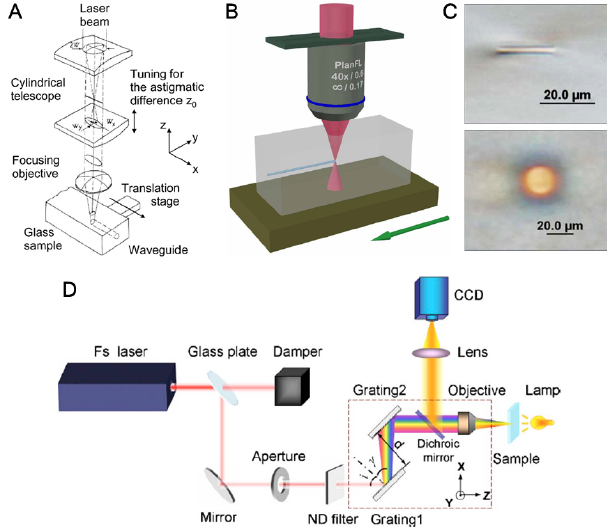
Figure 5: (A) Astigmatic beam shaping using a cylindrical telescope in front of the focusing objective. With permission from [69]. Copy- right 2003 The Optical Society. (B) Slit beam shaping, reducing the numerical aperture and thus expanding the focal spot transverse to the translation direction. With permission from [165]. Copyright 2009 The Optical Society. (C) Effect of the slit beam shaping on the waveguide cross section. The top microscope image corresponds to a waveguide written without a slit and the bottom image with a slit. With permission from [70]. Copyright 2005 The Optical Society. (D) Optical setup for simultaneous spatial and temporal focusing (SSTF) using two diffraction gratings in order to spectrally disperse the laser beam in front of the objective. With permission from